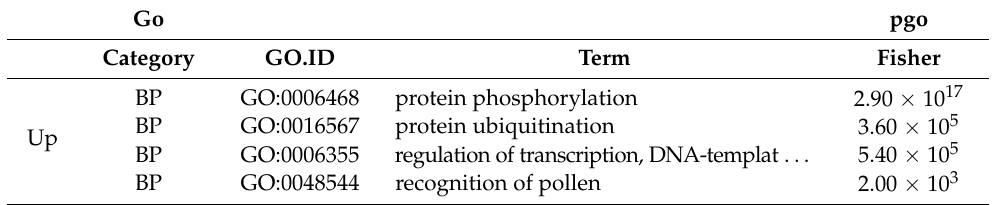
Table 3. Gene ontology (GO) analysis ( p ≤ 0.05) of the biological processes (BP) and cellular compo- nents (CC) up- (Up) or down-regulated (Down) in the flavedo of the freshly-harvested (FH) Pinalate fruit vs. the FH parental fruit. Only the DEGs ( p ≤ 0.05) that met a cutoff of |Log 2 FoldChange| ≥ 1 were considered in the analysis. Three biological replicates from each condition were